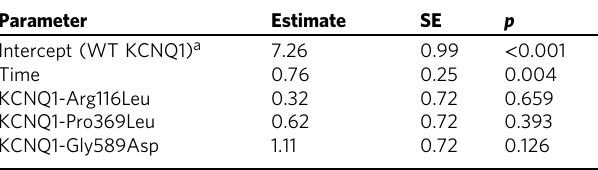
Table 2 Mixed linear regression model estimates for ACTH concentrations (ng/ml) measured in diluted medium samples from cells transfected with